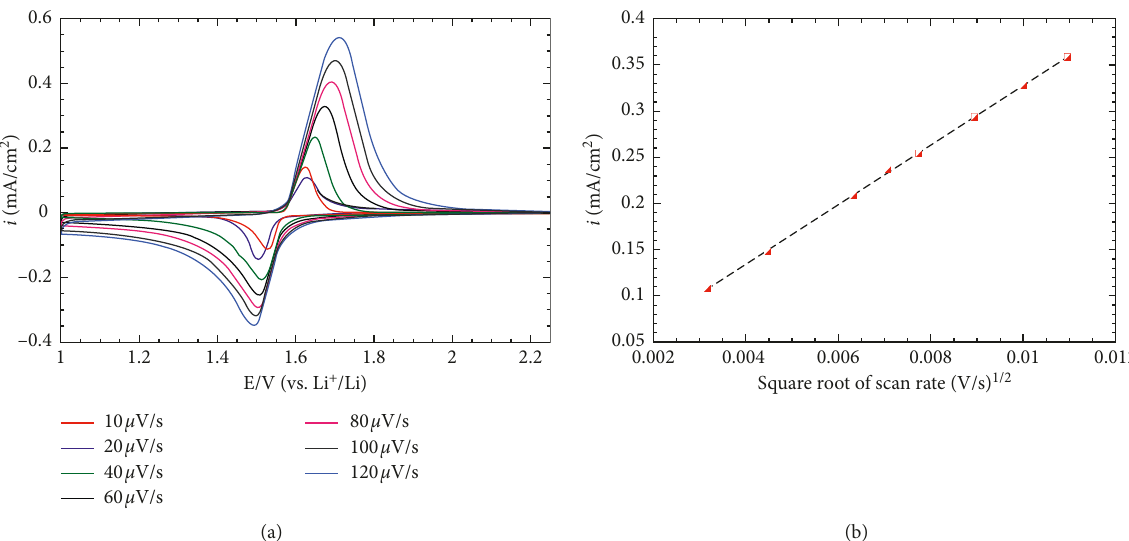
Figure 8: (a)CVcurvesundervariousscanratesfrom10 μ V/sto120 μ V/sand(b)currentdensityasafunctionofthesquarerootofthescanrate v 1/2